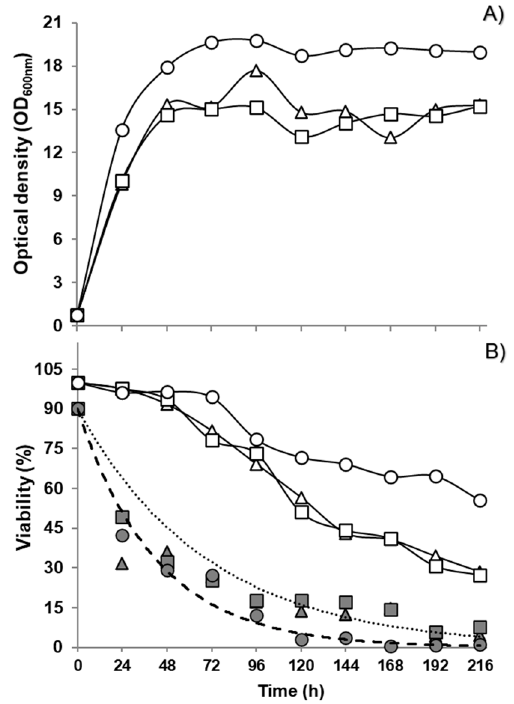
Figure 3. Culture growth on grape juice medium for the three Saccharomyces cerevisiae / Torulaspora delbrueckii mixed inoculum fermentations tested, expressed as: ( A ) Optical density at 600 nm, ( −Δ− ) Sc3Y4/Td1AN9, ( −□− ) Sc3Y8/Td1AN9; ( − O − ) Fermichamp/Td1AN9; and ( B ) Percentage of viability of the whole culture (open markers, determined by methylene blue staining) and that of Torulaspora delbrueckii as determined on WL Differential and WL Nutrient agar media, (···· ····) Sc3Y4/Td1AN9, (- - - - - -) Sc3Y8/Td1AN9; (- - - ● - - -) Fermichamp/Td1AN9. Exponential decay fittings shown with dotted and slashed lines. Standard deviations were always less than 10%; hence, the deviation bars are omitted in the graphs for clarity.